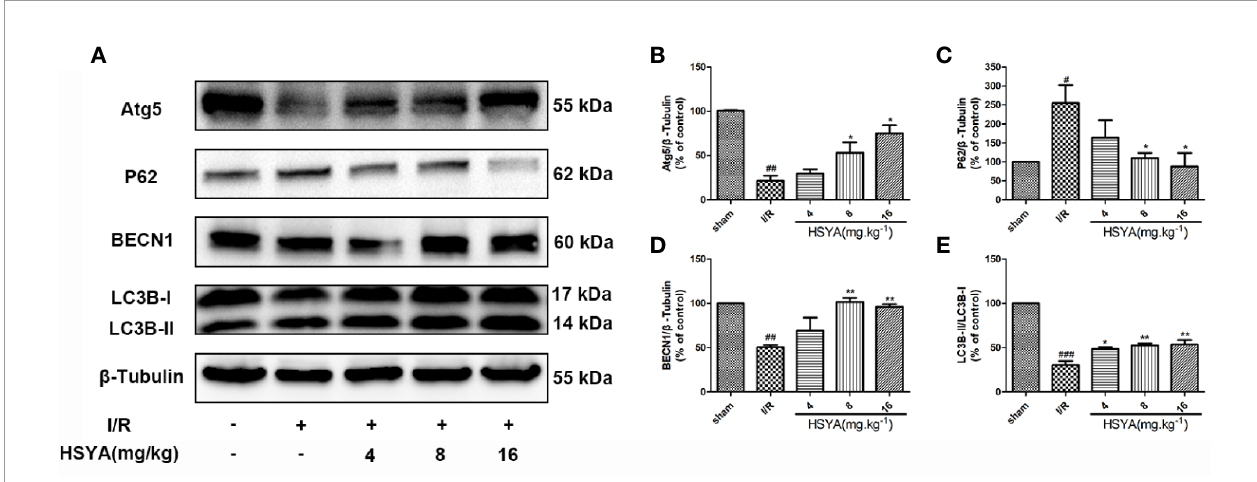
FIGURE 5 | Hydroxysaf fl or yellow A (HSYA) induces autophagy in the myocardium. (A) Myocardial Atg5, P62, BECN1, and LC3B expressions were assayed by western blot analysis. (B – E) Quanti fi cation of protein expression. Data are presented as means ± SEM. # P < 0.05, ## P < 0.01, ### P < 0.001 vs . the sham group,